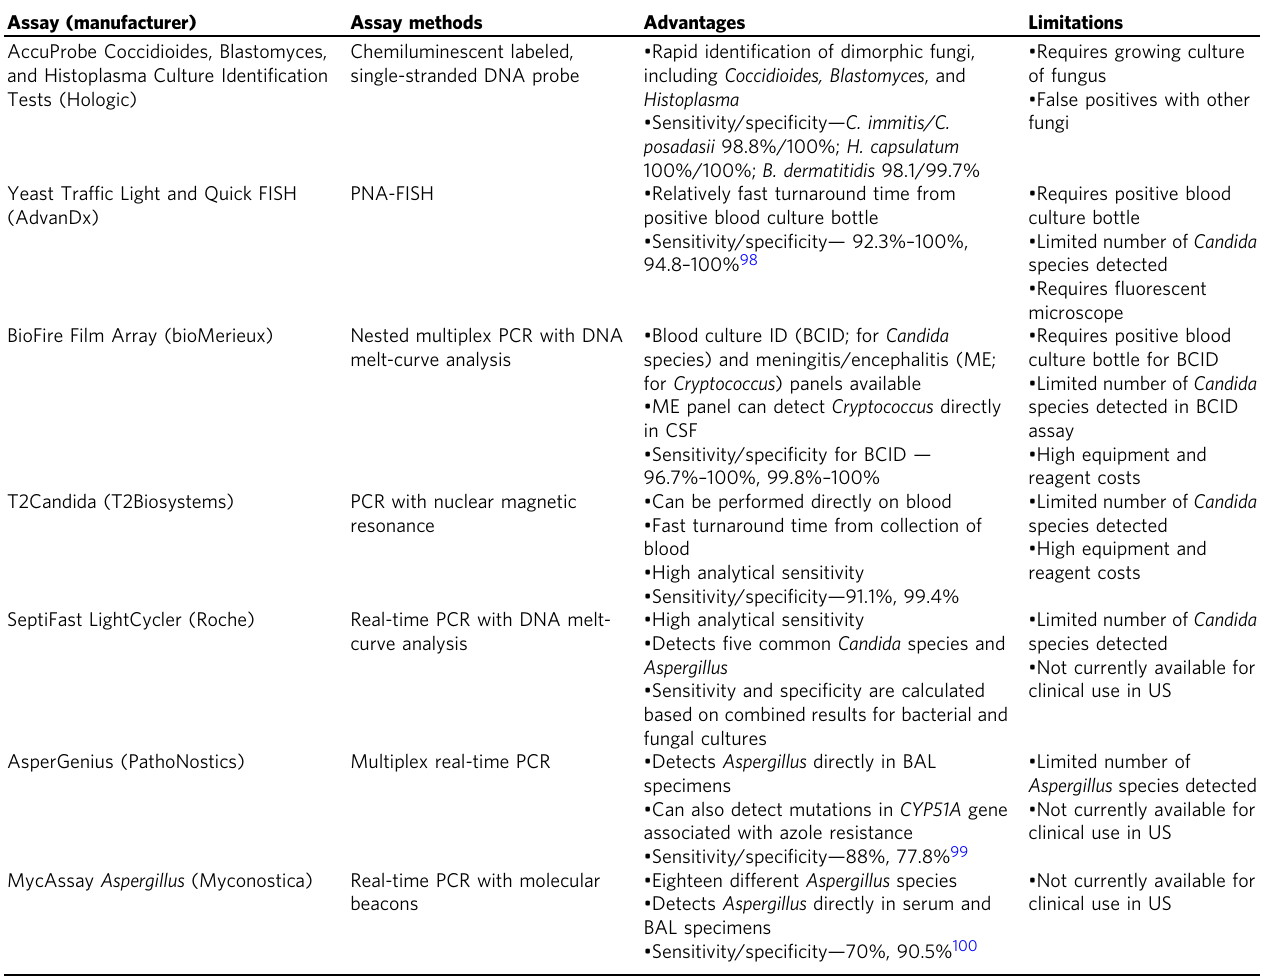
Table 3 Examples of molecular assays for fungal infections with FDA clearance for clinical use or CE-IVD marked for use in